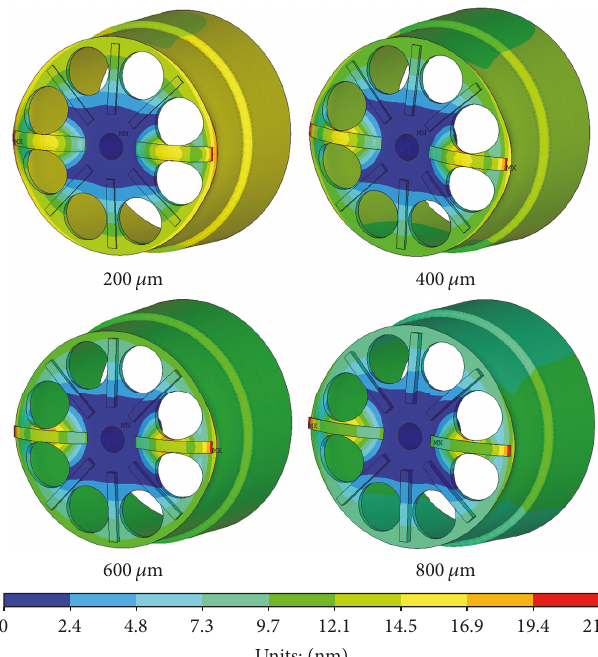
Figure 3: The selected finite element simulation results of vibrational amplitudes actuated by piezoelectrodes with different thickness.